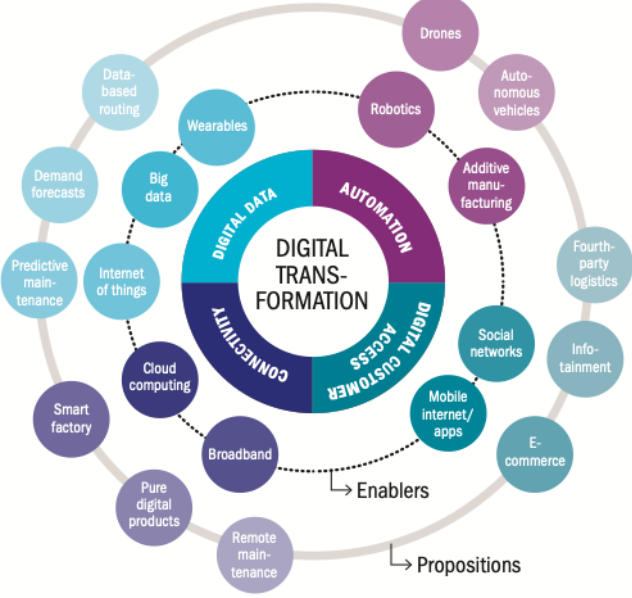
Figure 1. Digital transformation drivers, according to